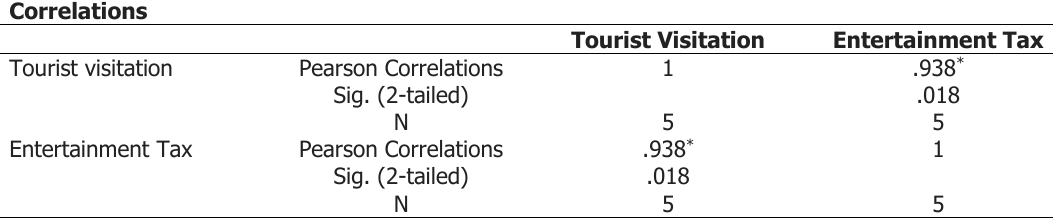
Table 2. Correlation Coefficients of Variable X with